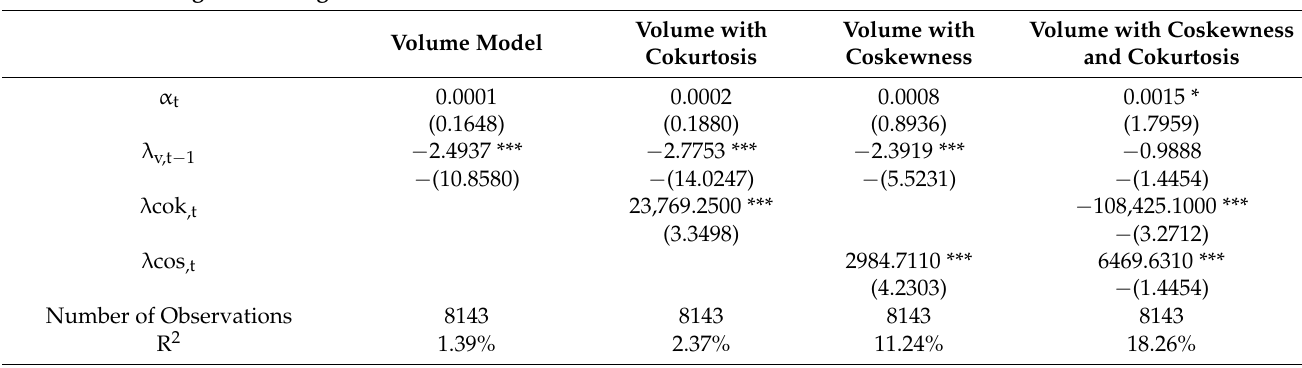
Table 1. Different augmented volume models with cokurtosis and coskewness for daily returns of Colombian electricity spot